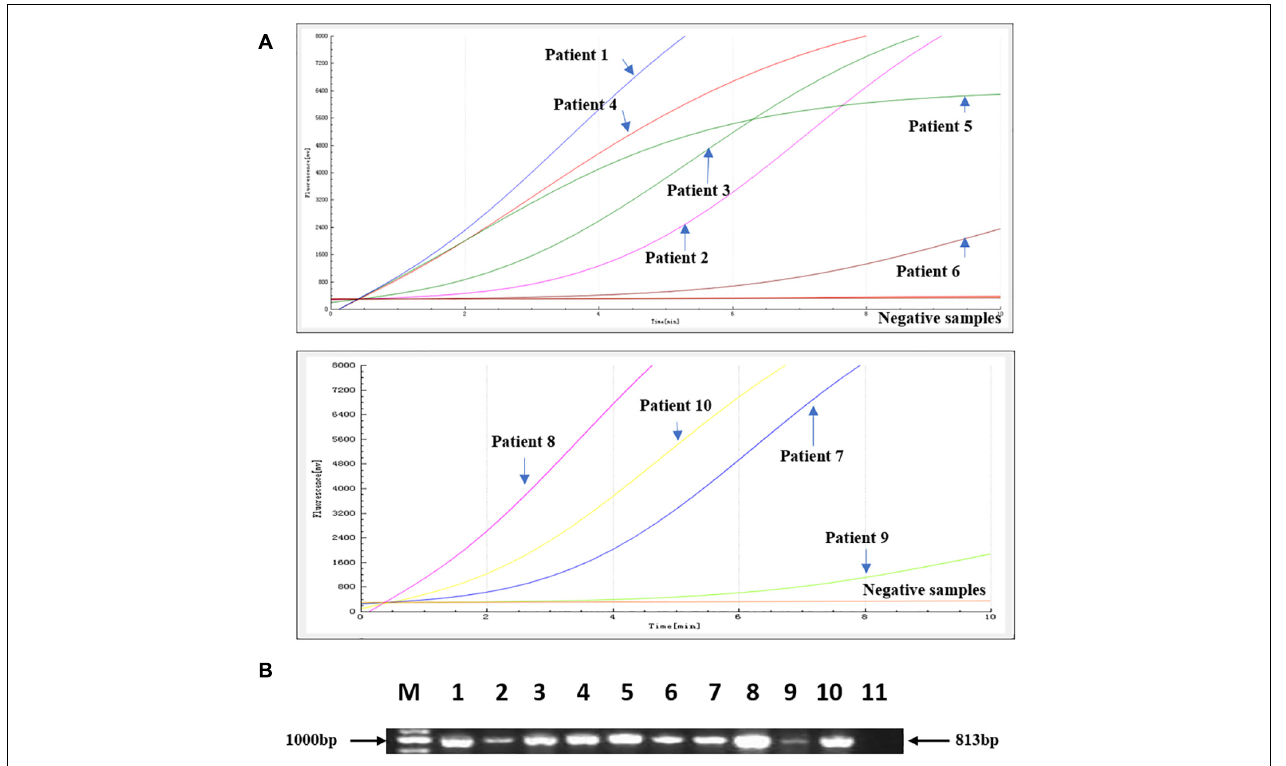
FIGURE 4 | Comparison of the RAA detection results with standard PCR on 112 clinical samples. Ten positive samples were identified. (A) The RAA detection results from the 10 positive samples. (B) The PCR results from the same 10 positive samples. M: Marker, 1–10: The 10 positive samples for patients 1–10; 11: negative